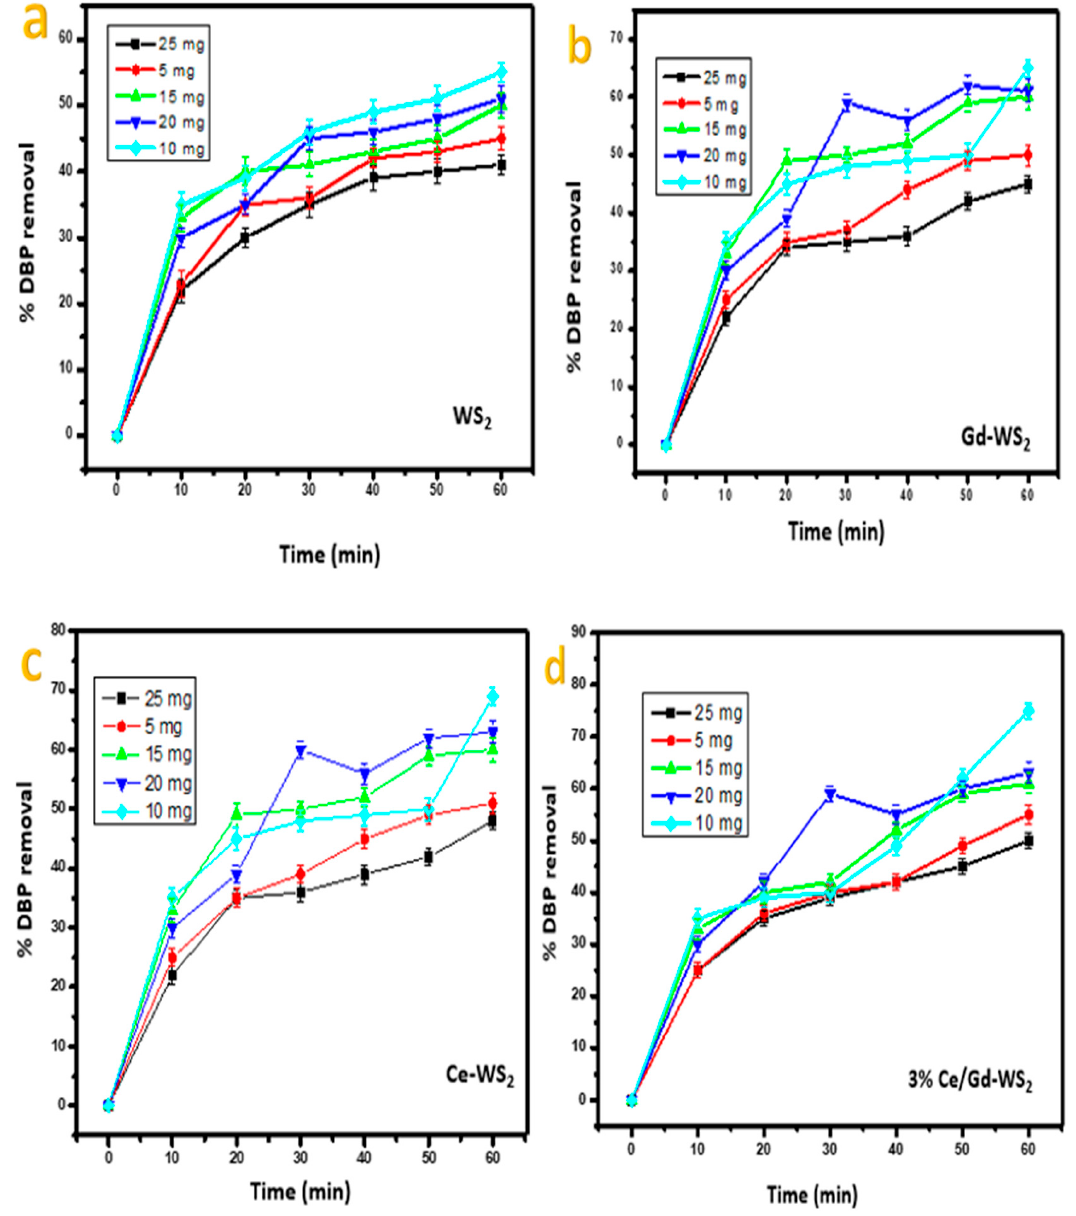
Figure 4. The effect of photocatalyst loading using ( a ) pristine WS 2 , ( b ) Gd-WS 2 , ( c ) Ce-WS 2 , and ( d ) 3% Ce/Gd-WS 2 towards the photodegradation of dibutyl phthalate.